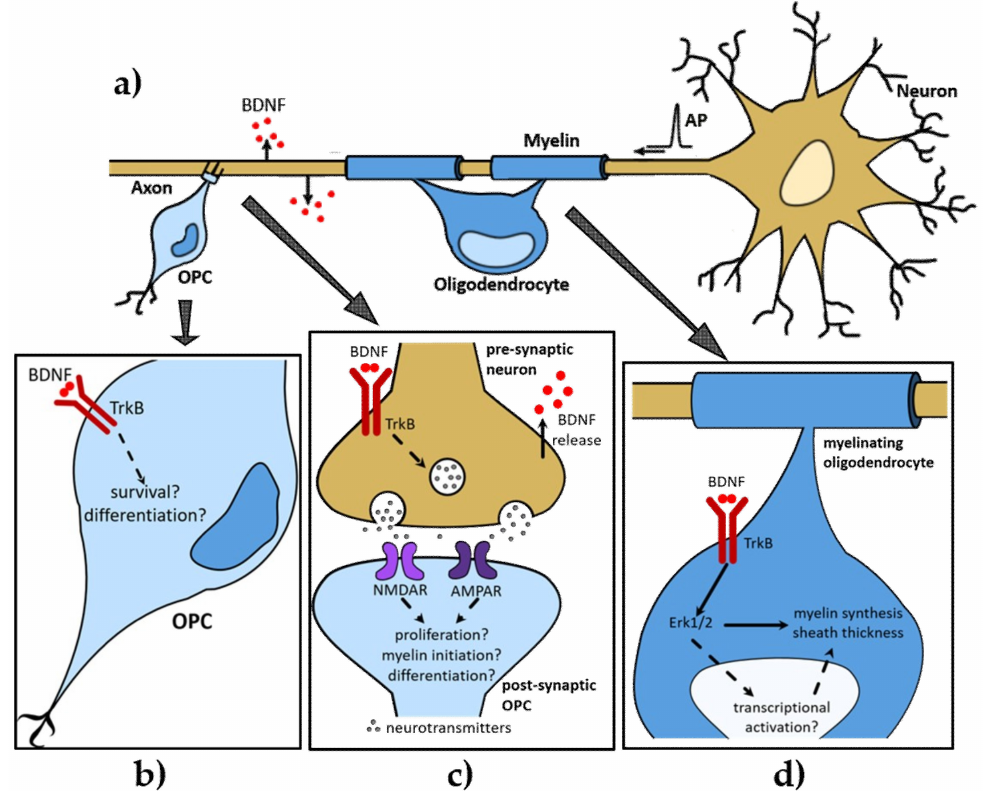
Figure 1. Schematic proposing the multi-faceted roles of brain-derived neurotrophic factor (BDNF)-tropomyosin-related kinase B (TrkB) signalling in central nervous system (CNS) myelination. ( a ) The myelinating process requires the oligodendrocyte progenitor cell (OPC) to contact the axon and differentiate into the mature oligodendrocyte that ensheaths the axon with myelin. Action potential (AP) firing by active neurons results in the release of BDNF along the axon. BDNF-TrkB signalling ( b ) could influence OPC survival and differentiation in development and after myelin injury and ( c ) promotes activity-dependent myelination by modulating glutamatergic (NMDAR; AMPAR) neurotransmission. It is well established that ( d ) BDNF-TrkB signalling via extracellular-related kinase 1/2 (Erk1/2) promotes the synthesis of myelin proteins and this influences myelin sheath thickness. Not known are the molecular mechanisms that underpin this effect and it is hypothesised that the BDNF-TrkB-Erk cascade results in transcriptional activation controlling myelin protein expression. Dashed arrows: hypothesised outcome of TrkB signalling; solid arrows: reported mechanism and outcome of TrkB signalling. See text for